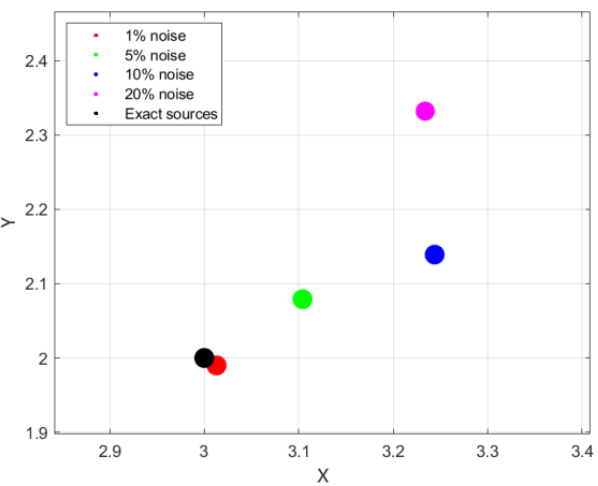
Figure 8. Reconstruction of one point source at different noise